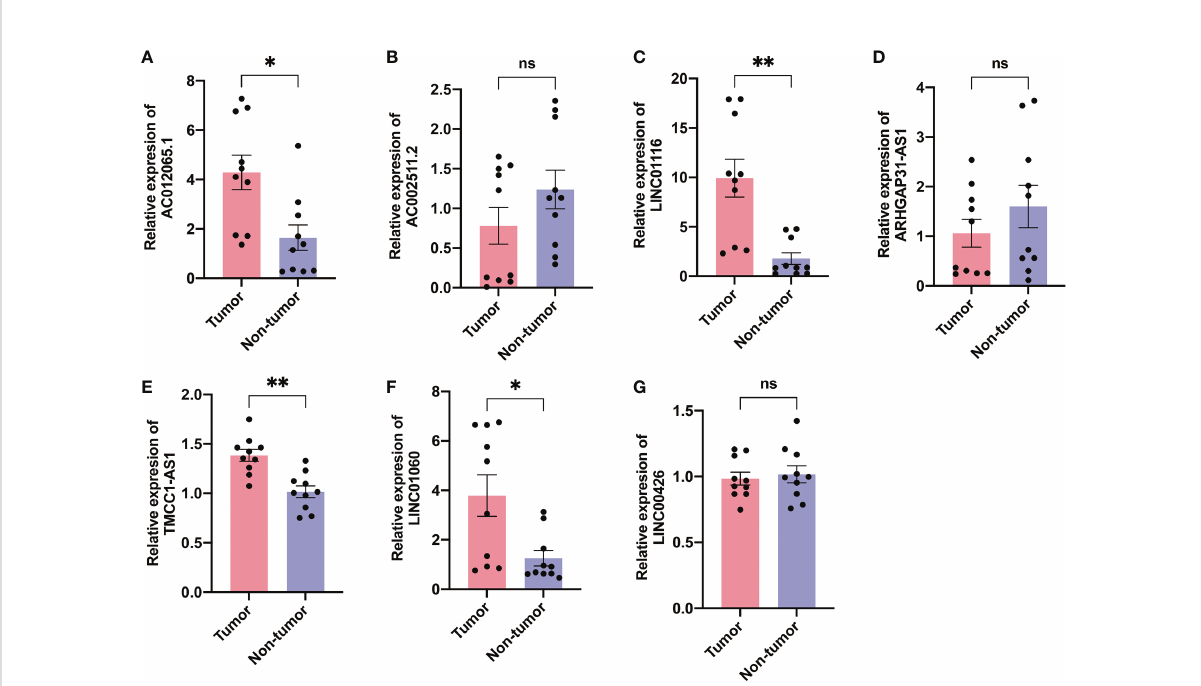
FIGURE 13 Validation of expression of the ALPS in human tissues. Expression analysis of (A) AC012065.1, (B) AC002511.2, (C) LINC01116, (D) ARHGAP31-AS1, (E) TMCC1-AS1, (F) LINC01060 and (G) LINC00426 in 10 pairs of liver cancer tissue samples. * P < 0.05; ** P < 0.01; ns, not signi fi